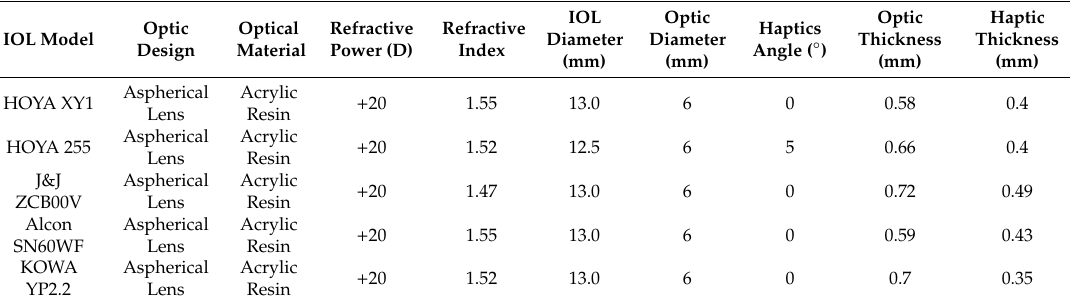
Figure 1. The six Intraocular lens (IOL) models used in this experiment. All are one-piece, soft-acrylic, +20-D refractive force, 6-mm optics diameter. ( a ) HOYA XY-1, ( b ) HOYA 255, ( c ) J&J ZCB00V, ( d ) Alcon SN60WF, ( e ) KOWA YP2.2, and ( f ) Nidek NS60YG. Table 1. Summary of IOL models.